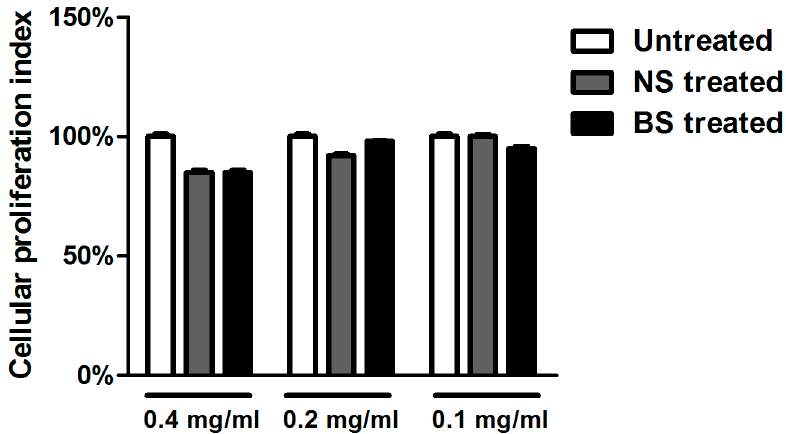
Figure 2. Viability assay in Vero cells treated with natural and blanched skin extracts. The cell viability was determined on the basis of ATP levels using the ViaLight ™ plus cell proliferation and cytotoxicity bioassay kit (Lonza Group Ltd., Basel, Switzerland). Vero cells were treated with three different concentrations of NS and BS almond extracts (0.4 mg/mL, 0.2 mg/mL and 0.1 mg/mL). 24 h post-treatment, they were collected, and the luminescence value was converted into the cell proliferation index (%) as described in the Materials and Methods. The assay was performed as the means of triplicates ± SD, and * indicates significant changes ( p ≤ 0.001).